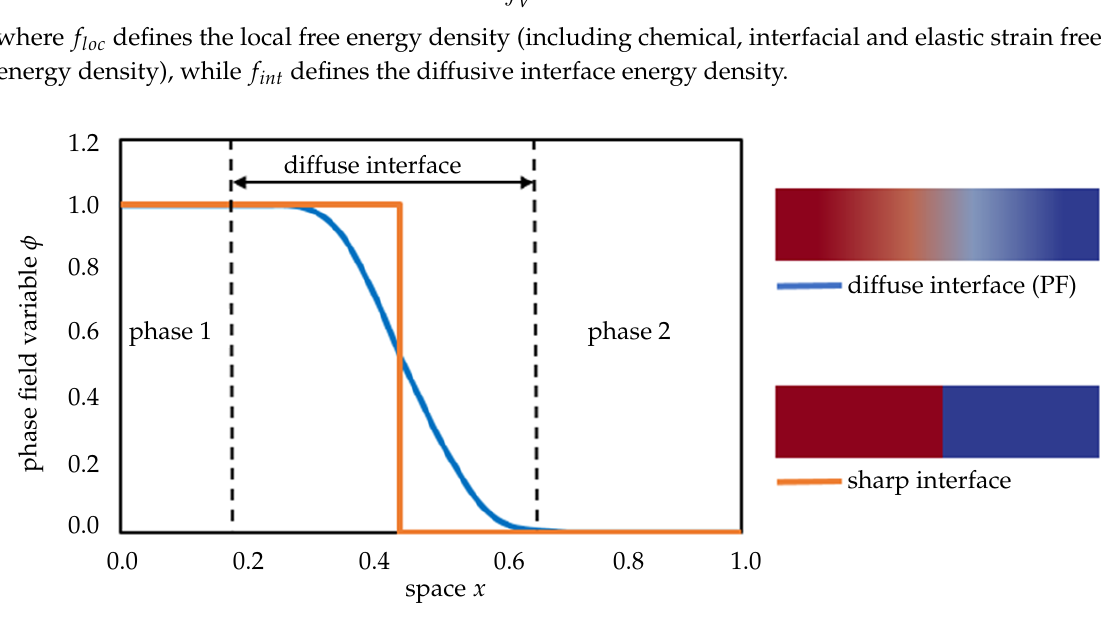
Figure 6. Schematic representation of sharp interface model and phase-field